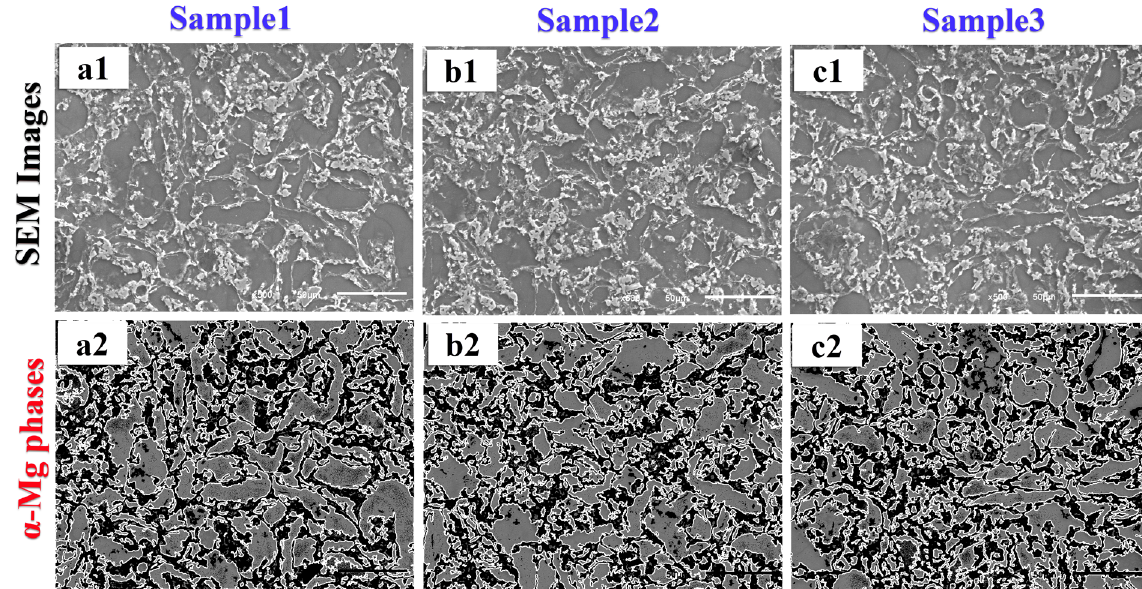
Figure 7. Detected grains using CV technology for samples 1, 2, and 3 (horizontal ones refer SEM images and phases; vertical ones refer Samples 1, 2 and 3; 500× magnification, scale bars with 50 µm).